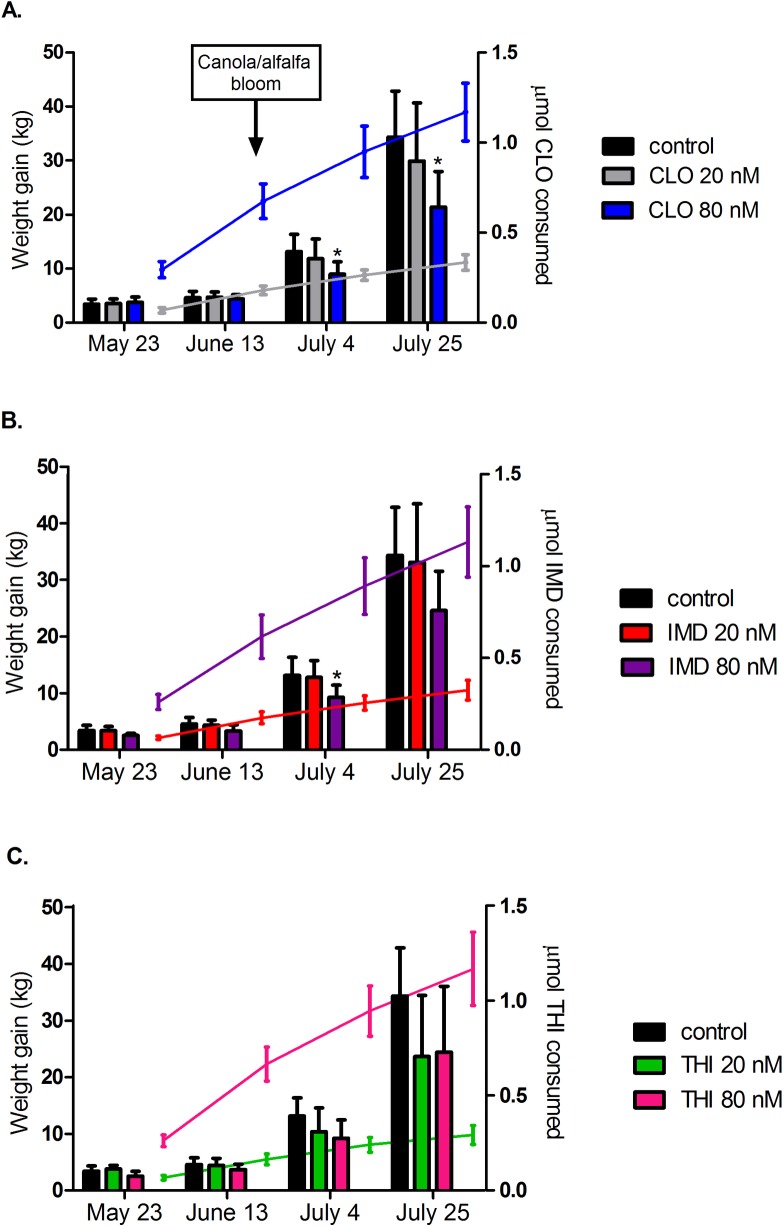
Cumulative weight gain of colonies exposed to sublethal doses of individual neonicotinoids for twelve weeks.Treatment colonies were exposed to clothianidin (CLO) (A), imidacloprid (IMD) (B), or thiamethoxam (THI) (C) at 20 or 80 nanomolar concentrations. Colonies exposed to 80 nM CLO (A) and 80 nM IMD (B) demonstrated significant decreases in weight gain from controls at weeks 9 and 12 and week 9, respectively. The bars show mean cumulative colony weight gain ± SD for each group (left y-axis). The curves show mean cumulative consumption of neonicotinoid per colony ± SD in micromoles for the treatment groups (right y-axis). * significantly different from control, P<0.01. The timing of the canola and alfalfa bloom surrounding the study site is indicated (A).